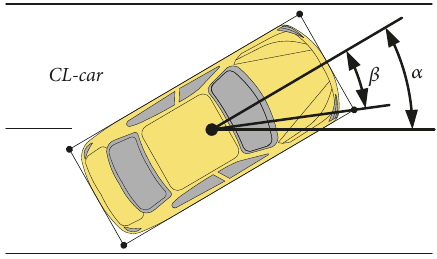
Figure 5: Angles of the lane change vehicle.